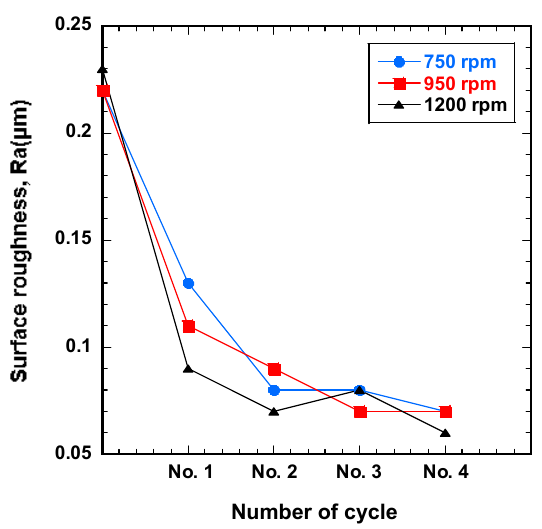
Figure 4. Surface roughness (Ra) as a function of the number of finishing cycles for different magnetic field rotation speeds with eco-friendly magnetic abrasive tools.